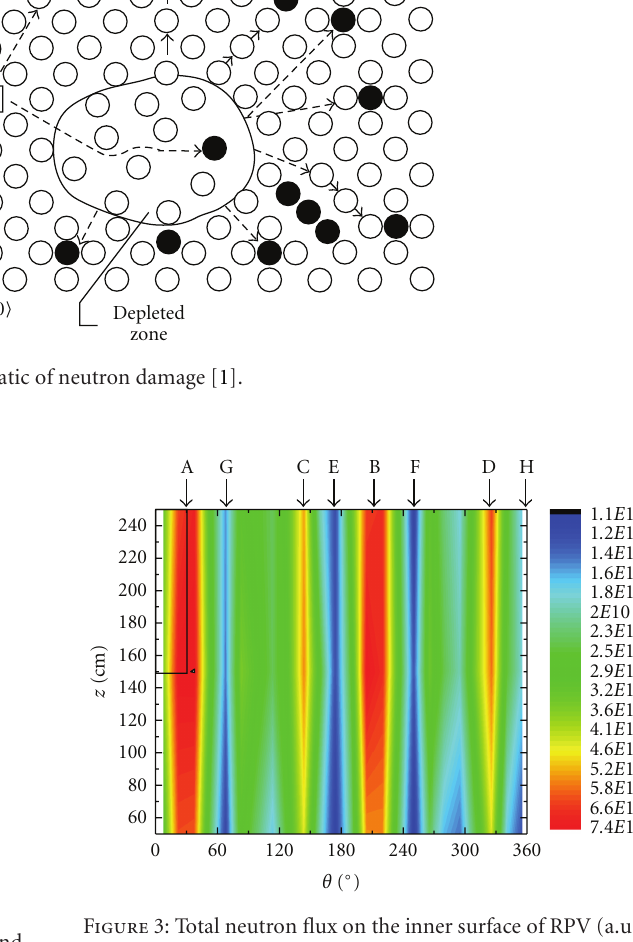
Figure 2: Axonometric view of the internal of the reactor, with and without fuel channels.